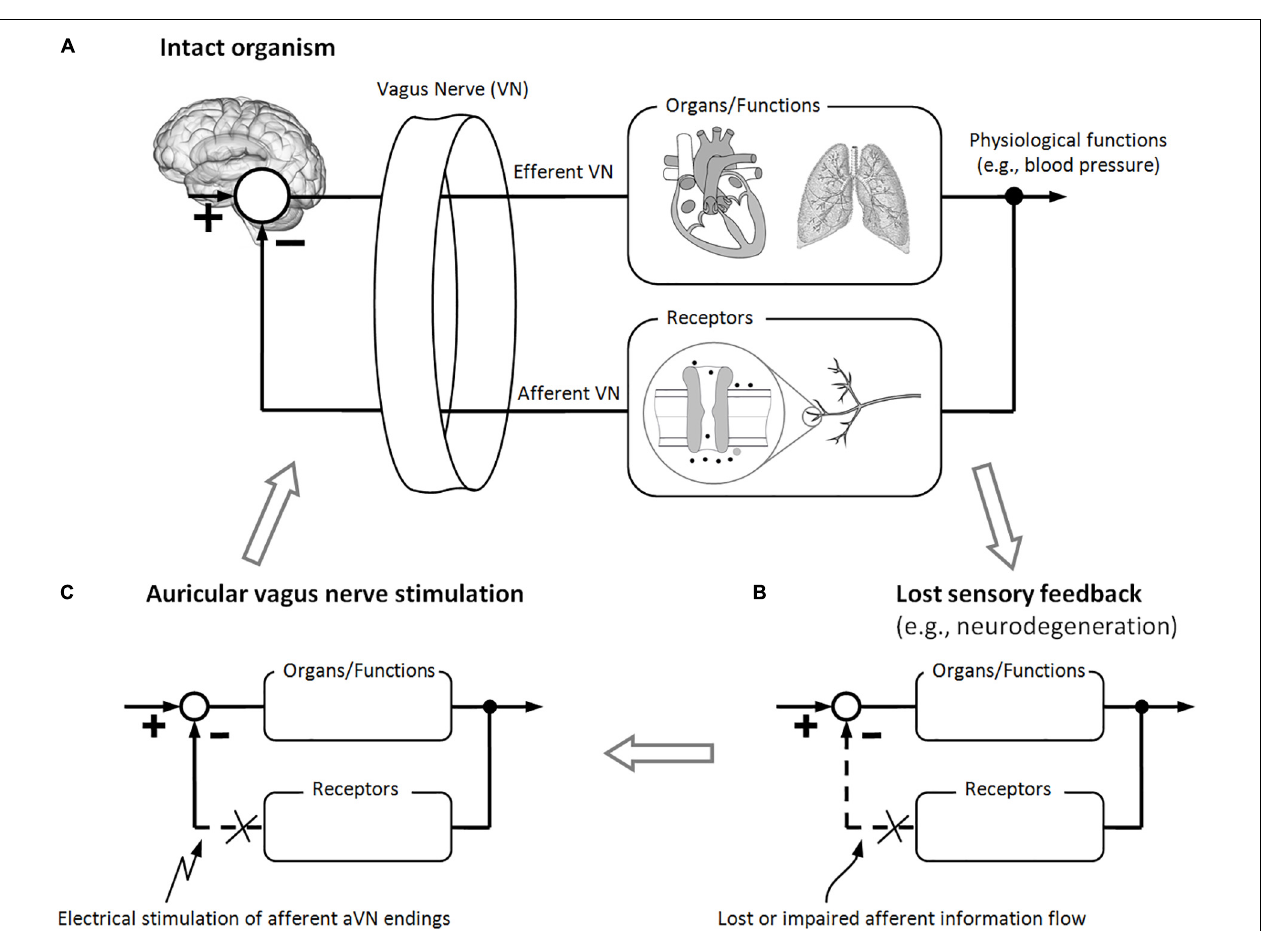
FIGURE 2 | Brain modulation via electrical stimulation of auricular vagus nerve (aVN) endings. (A) Intact feedback-loop which is composed out of efferent VN fibers (controlling different organs and functions) and afferent VN fibers (carrying sensory information back to the brain) for proper control of bodily organs and functions. (B) Different diseases may lead to a lost or impaired afferent feedback to the brain (e.g., due to neurodegeneration or maladaptive plasticity), which makes it impossible for the brain (the control station of the body) to adapt to changes in organs, functions, and/or environmental factors. (C) As a hypothesis, stimulation of aVN fibers substitutes the lost or impaired afferent feedback to the brain while inducing systemic regeneration processes. These processes, in turn, may lead to sustainable recovery of controlled organs and functions as well as recovery of the relevant sensory